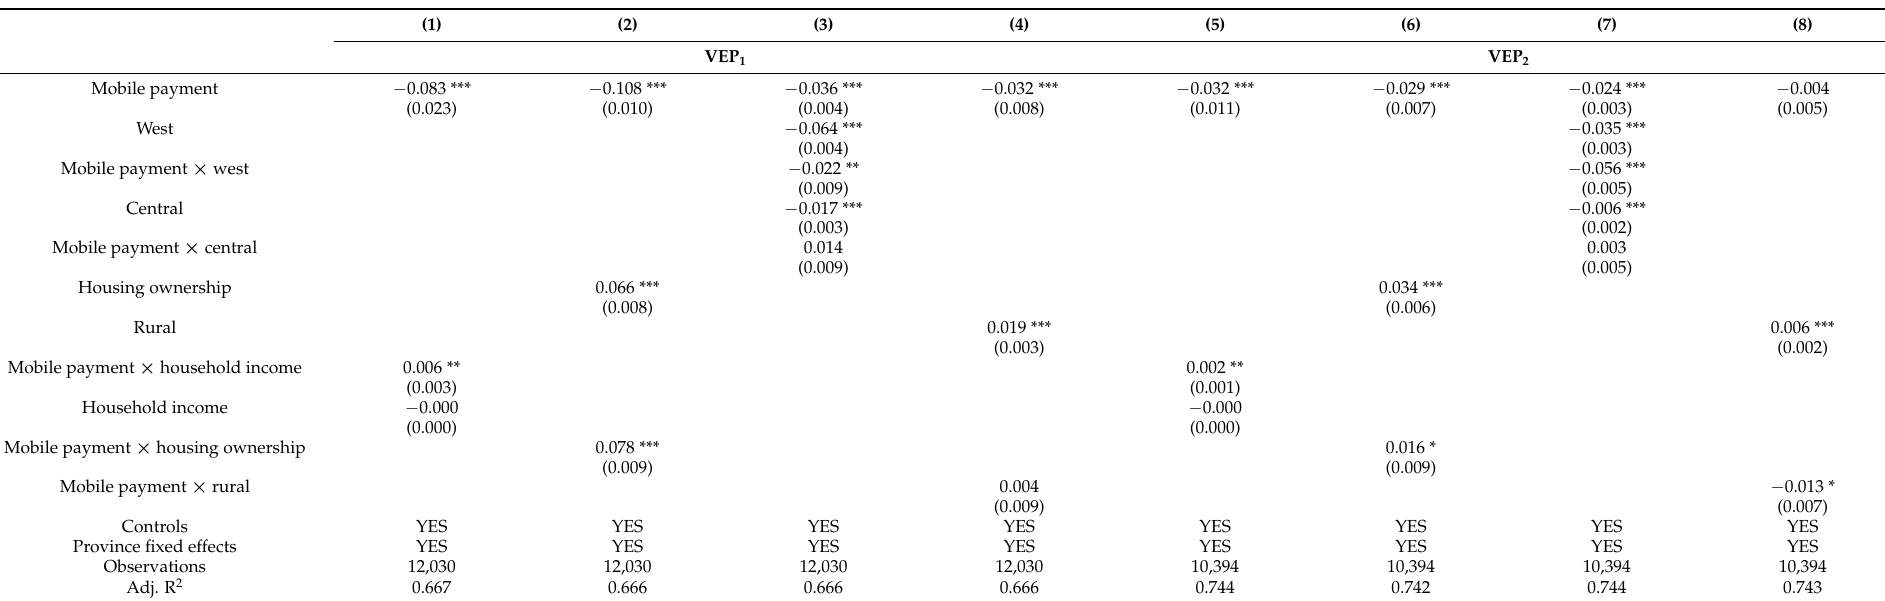
Table 8. Results of the heterogeneity